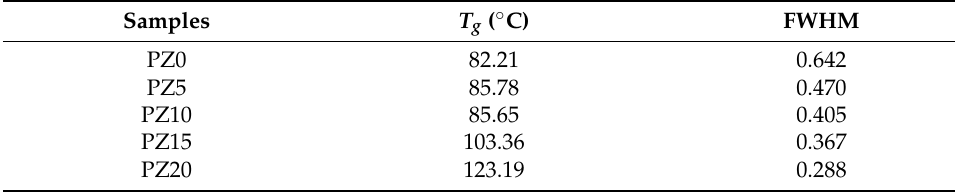
Table 2. Summary of T g and FWHM of polymer blend SPEs.